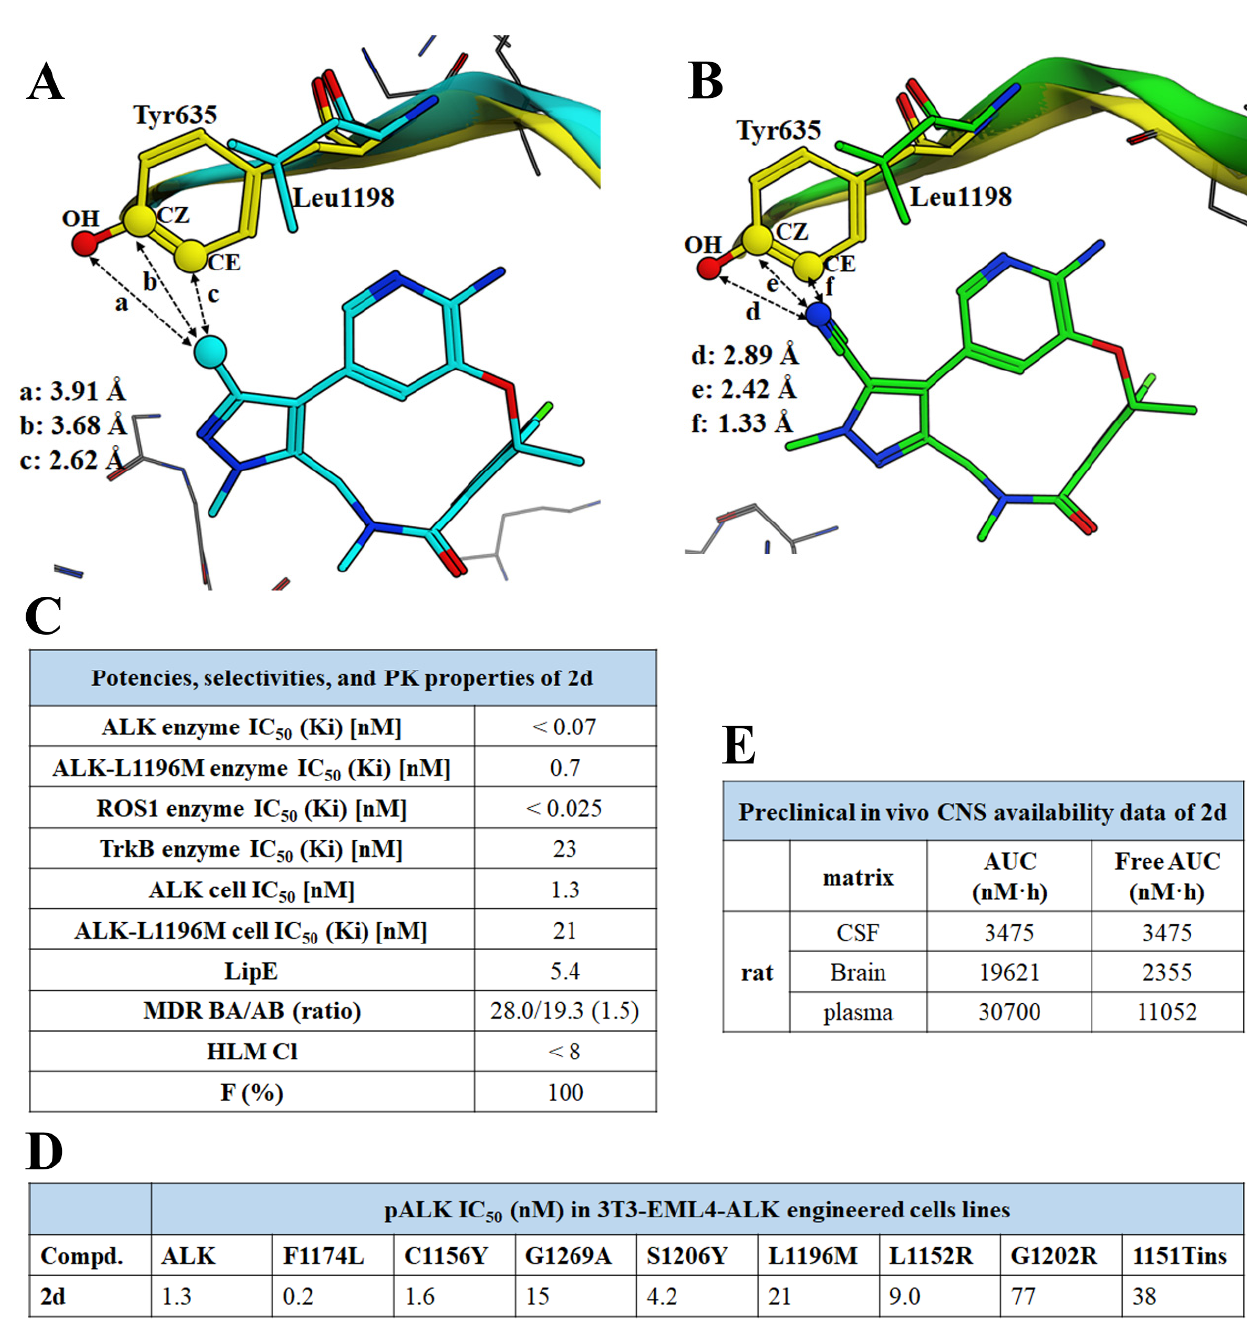
Figure 2. ( A ) 2c from ALK cocrystal structures (PDB: 4CMU, cyan) aligned with TrkB (PDB: 4AT3, yellow). Distances were measured between the methyl carbon atom of 2c and the terminal atoms (OH, CZ, CE) of Tyr635, respectively. ( B ) 2d from ALK cocrystal structures (PDB: 4CLI, green) aligned with TrkB (PDB: 4AT3, yellow). Distances were measured between the nitrile nitrogen atom of 2d and the terminal atoms (OH, CZ, CE) of Tyr635, respectively. ( C ) Summary of potencies, selectivities, and pharmacokinetic properties of compound 2d . ( D ) pALK inhibition activity of com- pound 2d against ALK and mainly clinical mutants of ALK. ( E ) Preclinical in vivo CNS pharmaco- kinetic study of 2d .